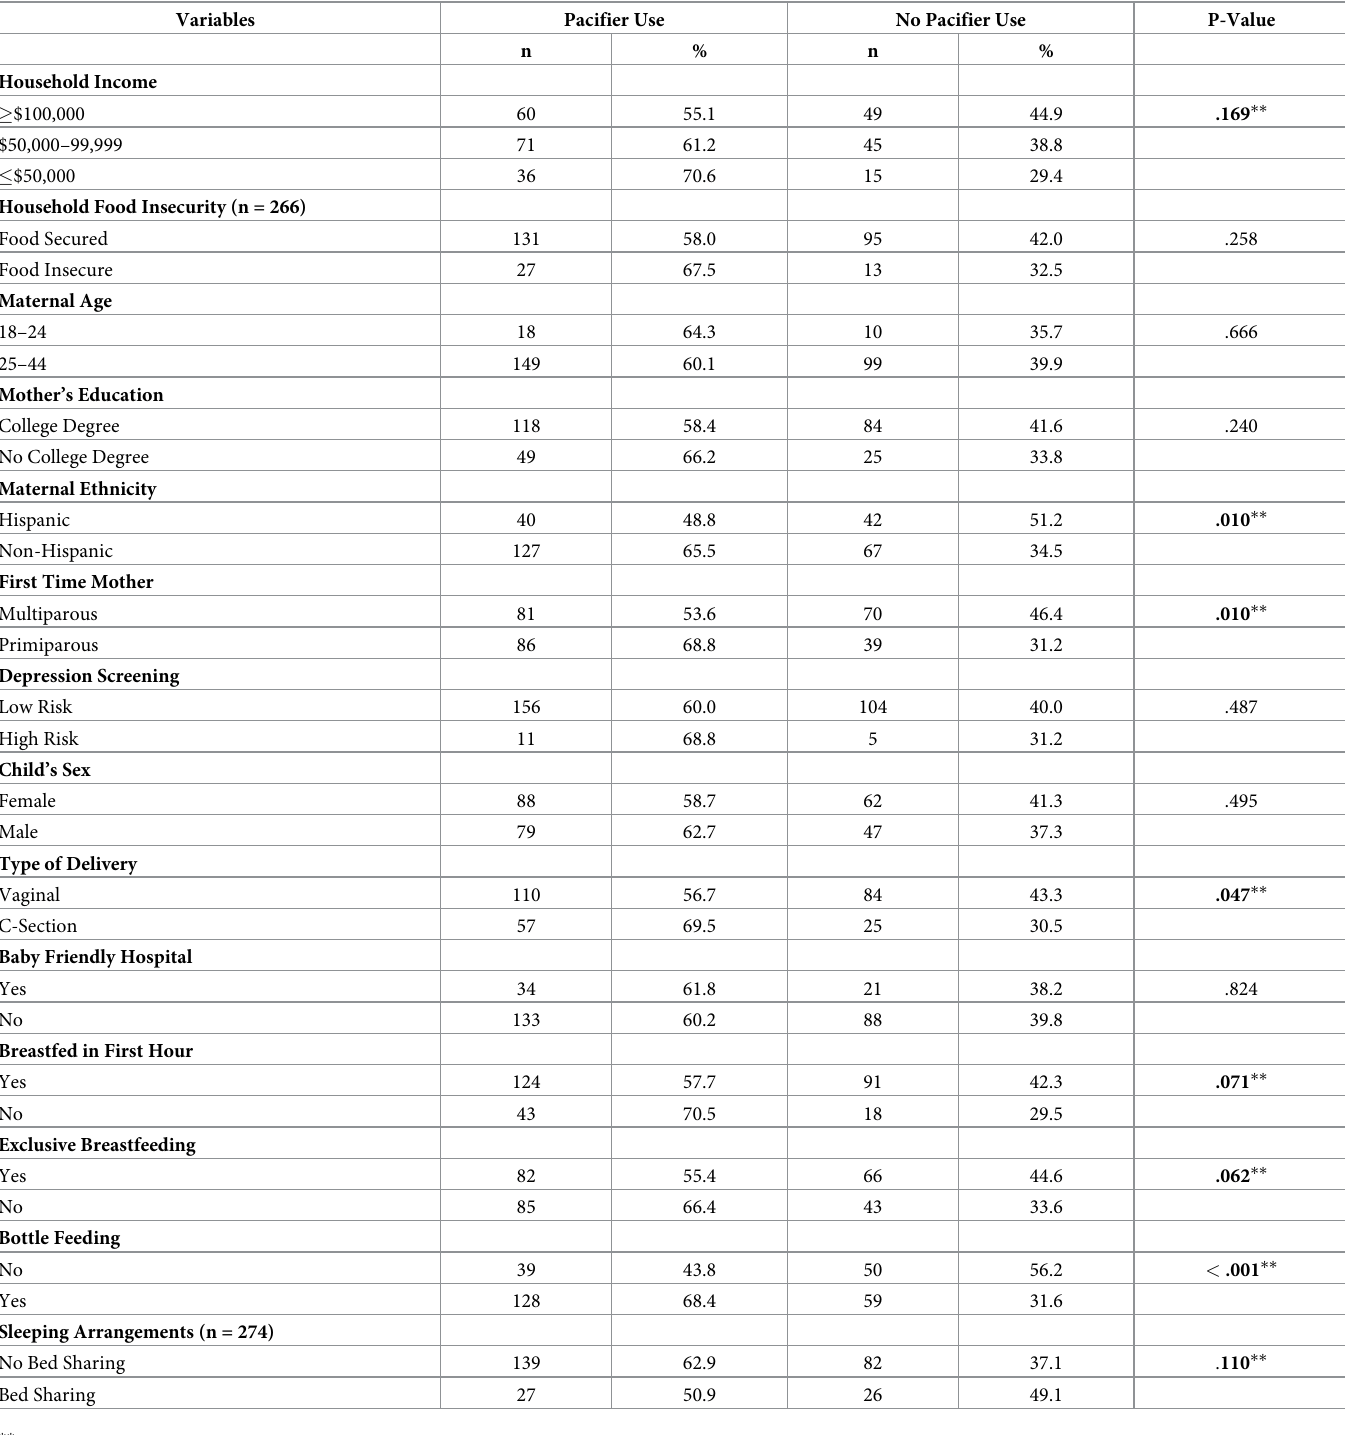
Table 2. Bivariate analysis of pacifier use by household, maternal, infant, and health care characteristics, and infant feeding and sleeping practices, 2021.